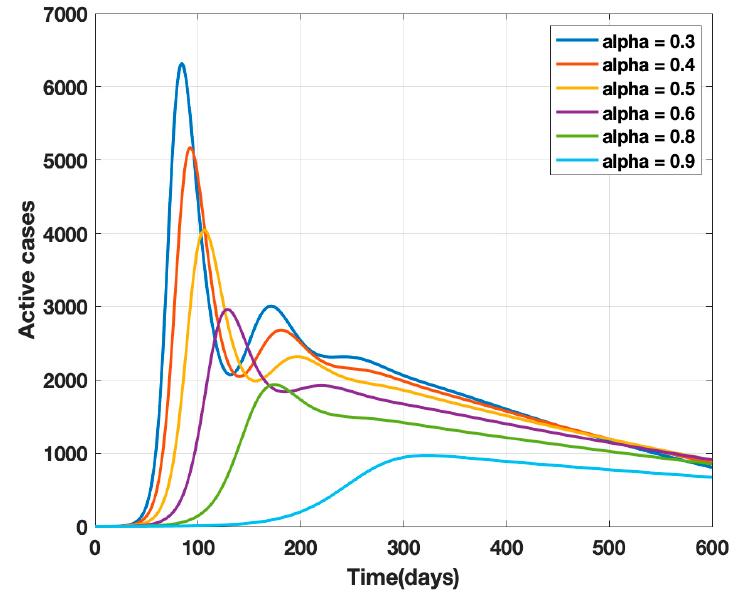
Figure 3. Sensitivity analysis of α and k for α = 0.3, 0.4, 0.5, 0.6, 0.7, 0.8, and k = 100, ρ − 1 = 10 days.